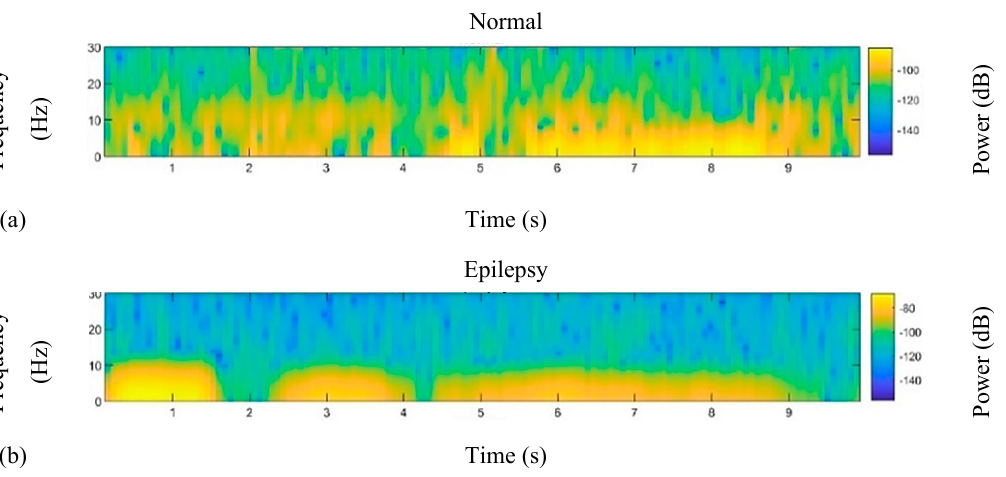
Figure 5. A Sample of power spectral density for one normal channel ( a ) and one epileptic ( b ) channel.